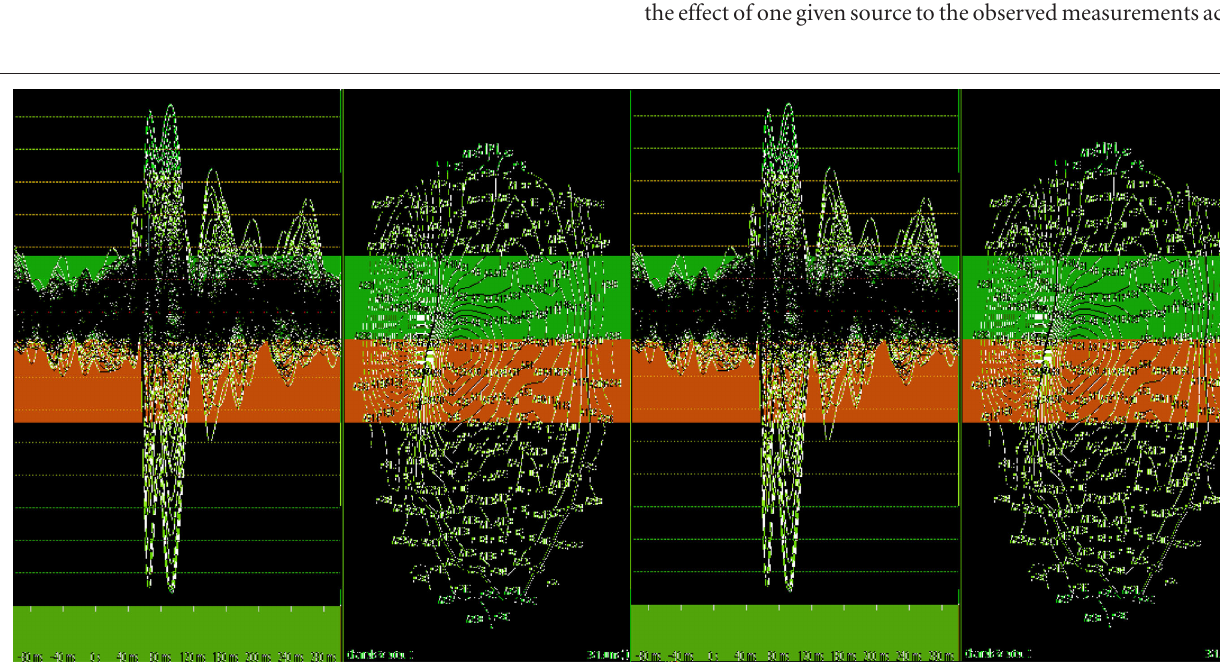
Figure 2 | Left panel: measured time series from all sensors; right panel: isofield magnetic map.